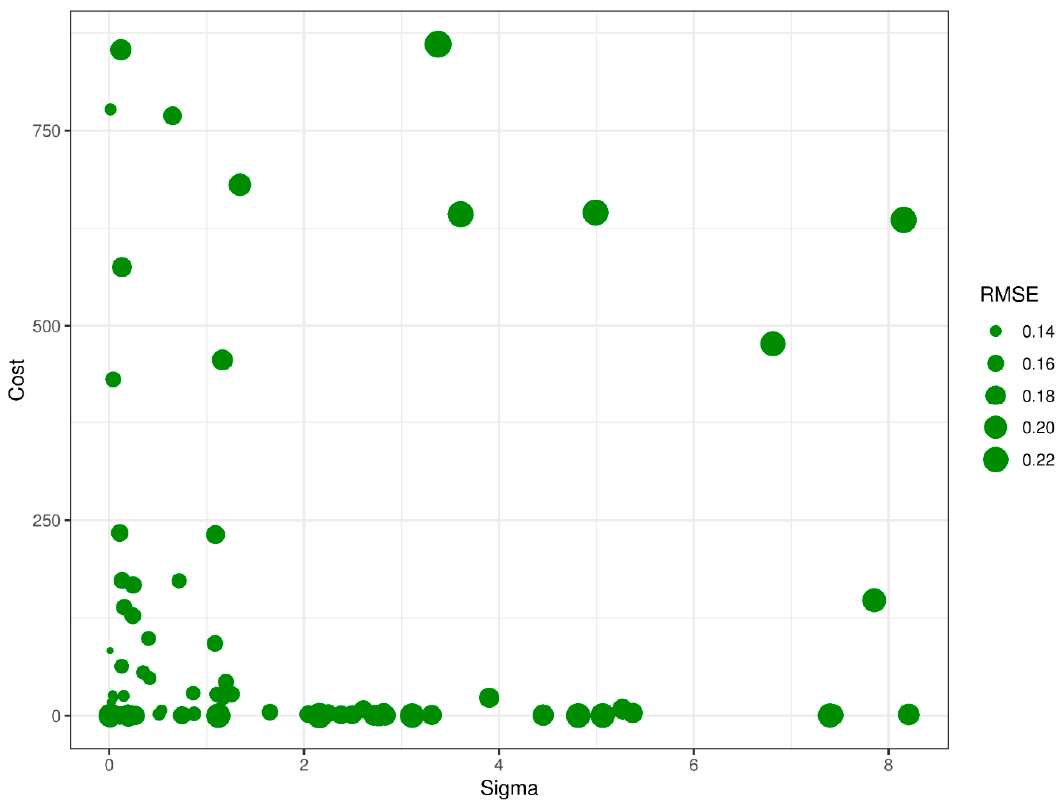
Figure 9. Performance of the support vector machine (SVM) model in this study.